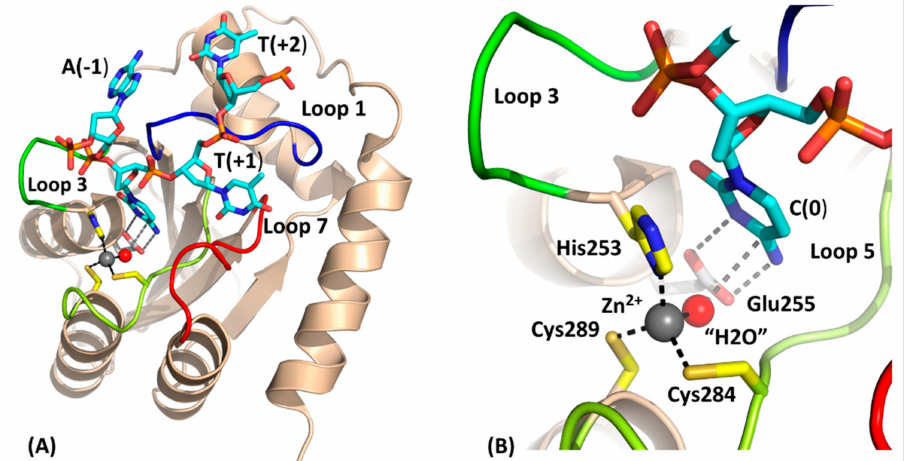
Figure 1. Structure of the catalytically competent C-terminal domain of A3B CTD with ssDNA (PDB code 5TD5). This construct differs from wild-type and is denoted A3B CTD * ( vide subra ). ( A ) Cartoon representation of the protein with active-site residues shown as colored sticks (red for oxygen, blue for nitrogen, yellow for sulfur and orange for phosphorus). Loops 1 (translated from A3A), 3 (truncated), 5, and 7 are shown respectively in blue, green, limon and red. The general acid-base Glu255 (Ala in structure 5TD5) has been modelled (carbon atoms in light grey) based on the substrate-free active enzyme (PDB code 5CQI). Zn is shown as a grey sphere and the nucleophilic H 2 O/OH - as a red sphere (Note: in crystal structure this is a Cl - ). The ssDNA is shown in stick form with carbon atoms distinguished by cyan coloring. Key hydrogen-bonding and incipient nucleophilic attack are shown as dark-grey dashed lines. ( B ) Magnified view of the active site showing key